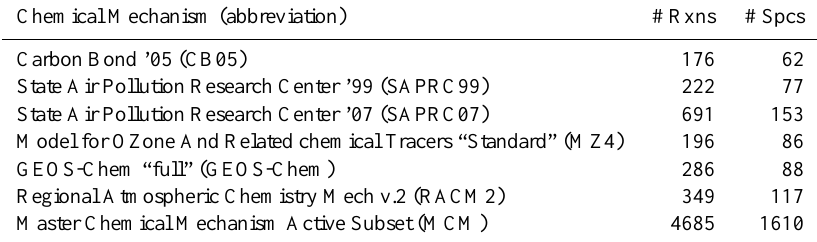
Table 1. Overview of chemical mechanisms in this study.